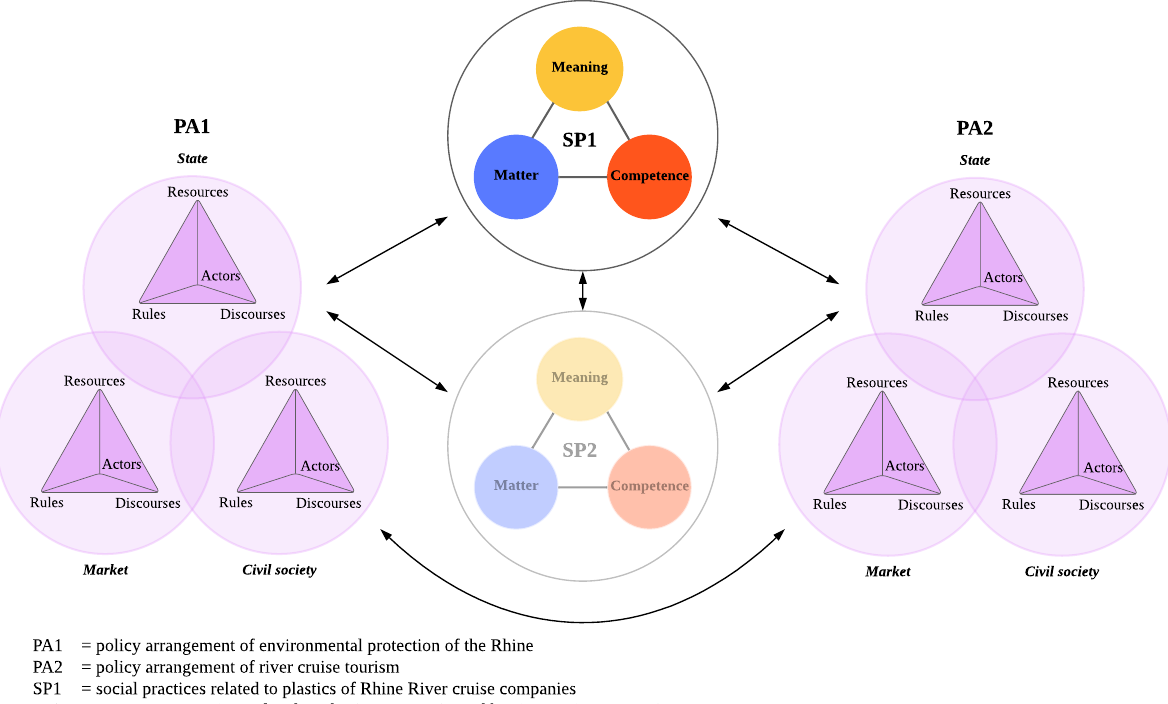
Figure 1. Conceptual